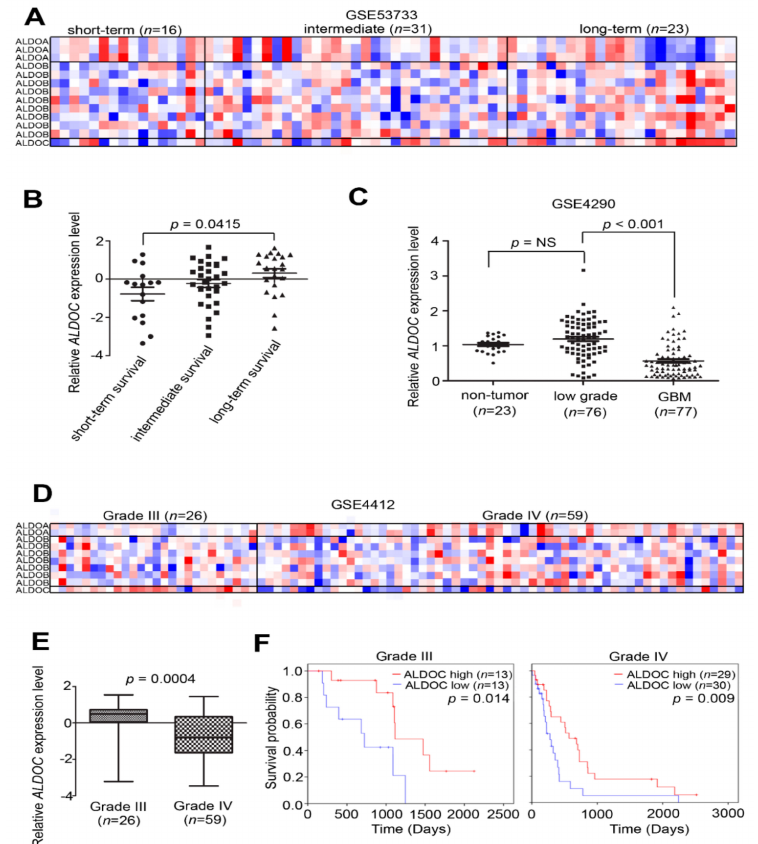
Figure 5. ALDOC mRNA expression correlated with survival curve and tumor grade. ( A ) A heat map showing the endogenous mRNA expression level of aldolase family members ALDOA, ALDOB, and ALDOC in GSE53733 ( n = 70). Short-term survival: < 12 months, long-term survival: > 36 months, and 12~36 months as intermediate. ( B ) A boxplot showing the distribution of ALDOC expression in clinical patients according to the survival rate in the GSE53733 cohort. ( C ) A boxplot showing the distribution of ALDOC expression in clinical patients according to the histology in the GSE4290 cohort. ( D ) A heat map showing the endogenous mRNA expression level of aldolase family members ALDOA, ALDOB and ALDOC in GSE4412 ( n = 84). ( E ) A boxplot showing the distribution of ALDOC expression in clinical patients according to the tumor grade in the GSE4412 cohort ( p = 0.0004). ( F ) Kaplan–Meier analysis of ALDOC expression at concurrently low or high levels, with the endpoint of overall survival probability by grade III or grade IV from the Kaplan–Meier Plotter database in glioblastoma patients, respectively. The significance of the di ff erences in E was analyzed using a Student’s t -test. The significance of the di ff erences in B and C were analyzed using the one-way ANOVA formula. All cut-o ff values were set before analysis, and all tests were